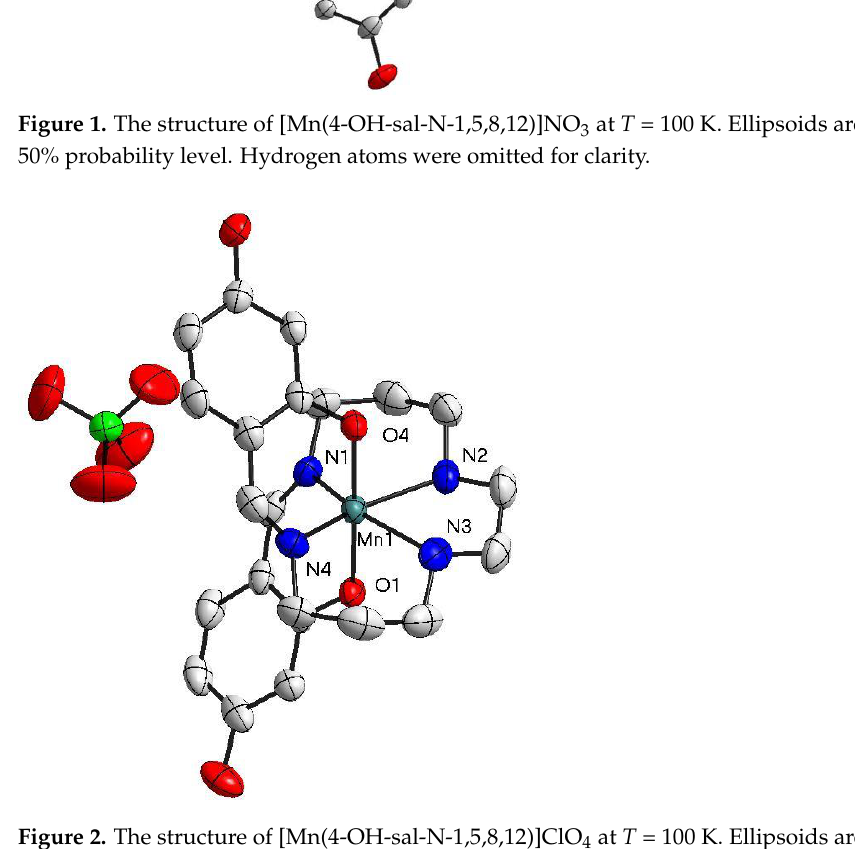
Figure 2. The structure of [Mn(4-OH-sal-N-1,5,8,12)]ClO 4 at T = 100 K. Ellipsoids are drawn at the 50% probability level. Hydrogen atoms were omitted for clarity.